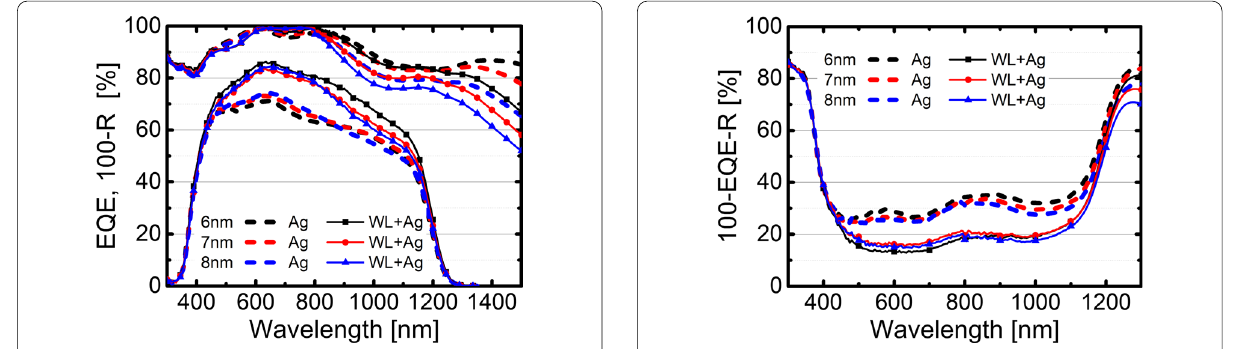
Fig. 5 The external quantum efficiency (EQE) and the reflectance subtracted from 100% (100%‑R) of CIGS cells using OMO electrodes with (full lines) and without (dashed lines) wetting layers for the three thickness levels of the Ag layer are shown. The best performing cell from the set of nine cells structured on each sample is shown